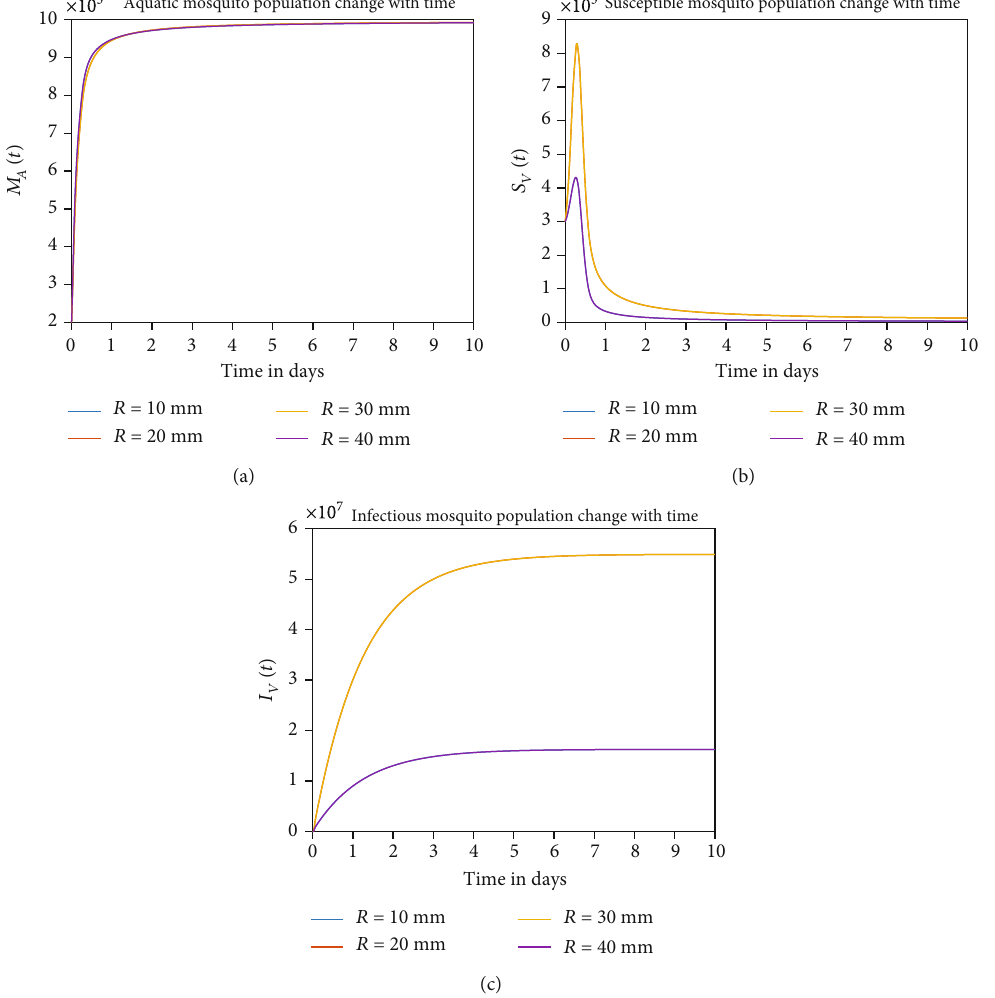
Figure 5: Change in mosquito population over time for rainfall values R = 10 mm, R = 20 mm, R = 30 mm, and R = 40 mm. (a) The number of aquatic mosquitoes over a period 10 days. (b) The number of susceptible mosquitoes over a period of 10 days. (c) The number of infectious mosquitoes over a period of 10